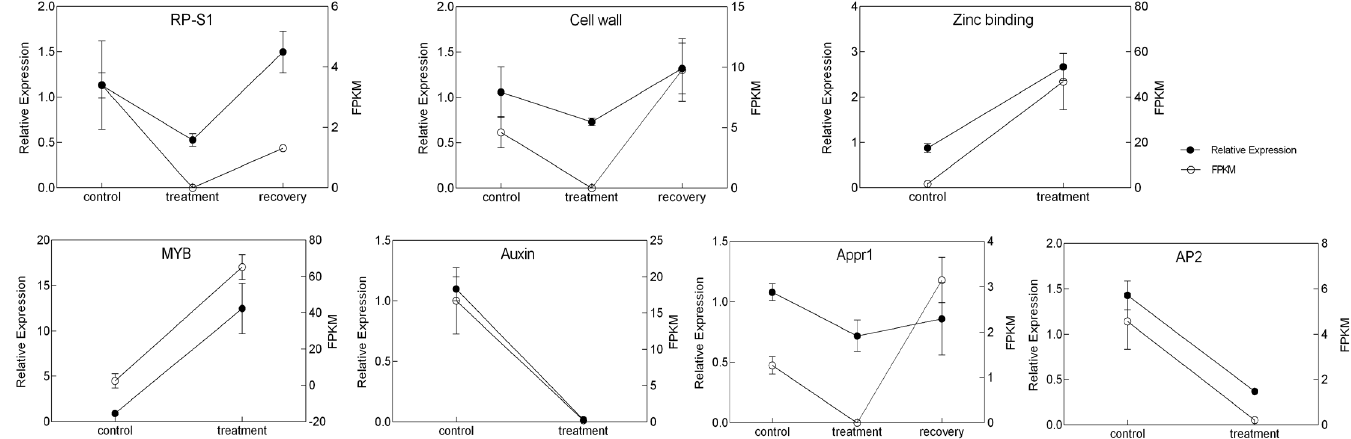
Fig 8. Relative patterns of gene expression by RNA-seq (shown in dark line) and qPCR (shown in gray line). The left coordinate axis shows the FPKM value of transcriptome data, and the right coordinate axis is the relative expression value as per qPCR.